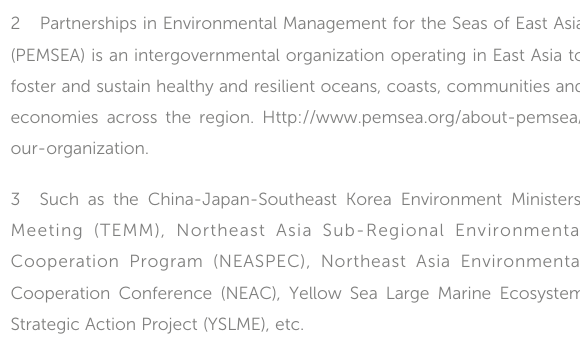
TABLE 2 Mass distribution